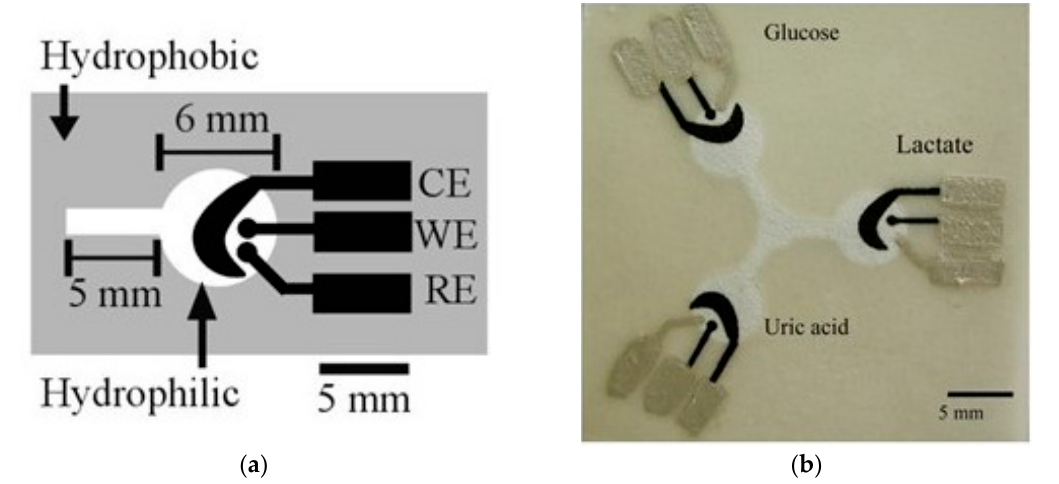
Figure 1. The first paper-based electrochemical analytical device developed using screen printing: ( a ) The basic design of each detection zone; ( b ) The fabricated sensor with three detection zones for multi-analyte detection. Reproduced with permission from [39], Copyright American Chemical Society, 2017.